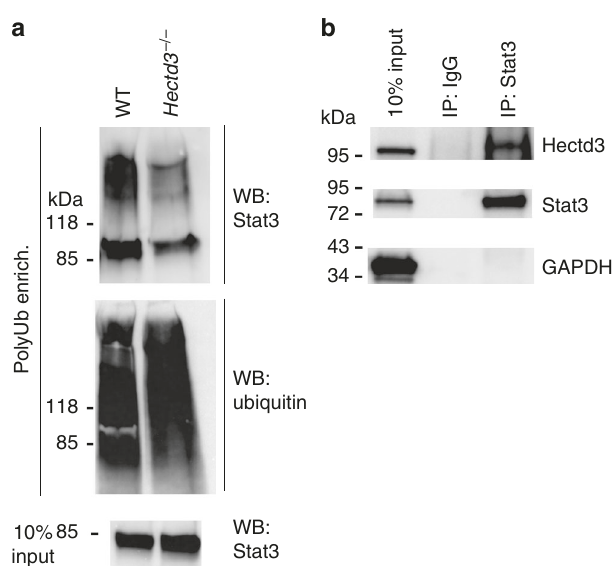
Fig. 7 Hectd3 interacts with and promotes Stat3 polyubiquitination. a Immunoblot of Stat3 and ubiquitin following polyubiquitinated protein enrichment of extracts from dLN CD4 + T cells of Hectd3 − / − or wild-type (WT) mice, 13 days following EAE induction. b Immunoblot of Hectd3 and Stat3 following Stat3 or IgG immunoprecipitation of protein extracts from dLN CD4 + T cells of WT mice 13 days following EAE induction. a , b Immunoblots are representative of three independent experiments. Source data are provided as a Source Data fi